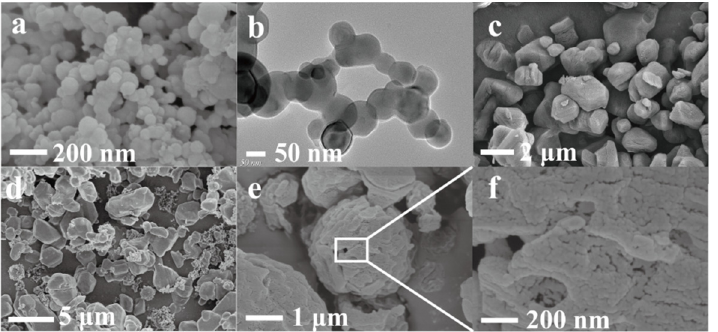
Figure 4. ( a ) SEM images of nAl, ( b ) TEM image of nAl, SEM images of ( c ) recrystallized FOX-7, ( d ) FOX-7/Viton@Al, ( e , f ) Viton@FOX-7@Al.